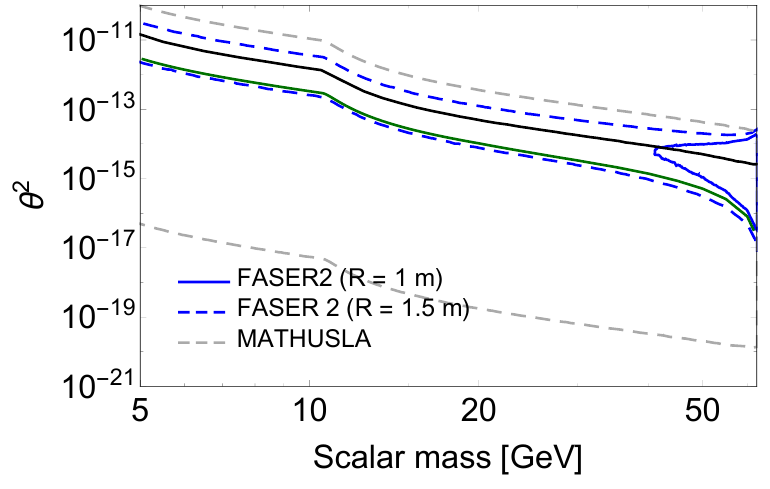
Figure 8 . Sensitivity of the FASER 2 to scalars produced in decays of Higgs bosons. Blue solid line encloses the region where one expects to observe at least 2.3 events, given the current con(cid:12)guration of the experiment (the radius of the decay vessel R = 1 m). A modest increase of the geometric acceptance (by changing the radius to R = 1 : 5 m) allows probing an order-of-magnitude-wide stripe for all masses (between blue dashed lines). The black solid line shows parameters for which l decay = L (used for our analytic estimates). Gray dashed line shows upper and lower regions of the MATHUSLA200 experiment where similar production from the Higgs bosons is possible (partially based on [61]). The green line is an analytic estimate, see text for details. Sensitivity estimates assume the 100% e(cid:14)ciency of the reconstruction of decay products but take into account geometric acceptance. The branching ratio BR( h ! SS ) is taken at the level of